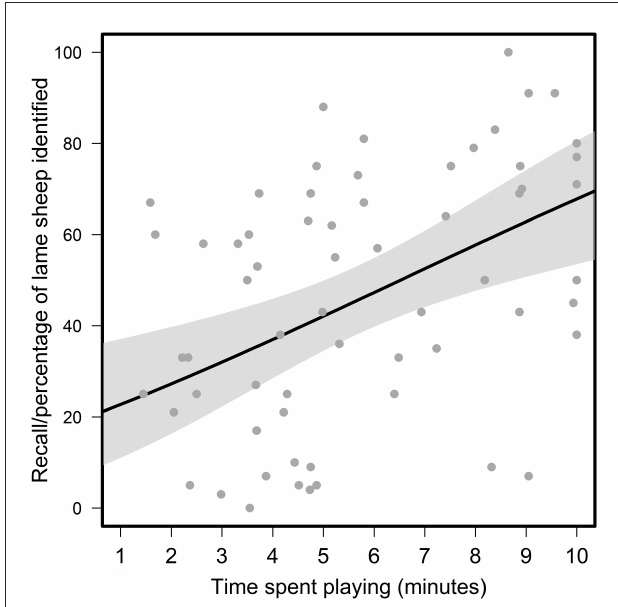
FIGURE6 Relationship between participants’ recall scores and the time they spent playing the game. Solid black line and shaded area represent the fit and 95% confidence interval of the linear model,